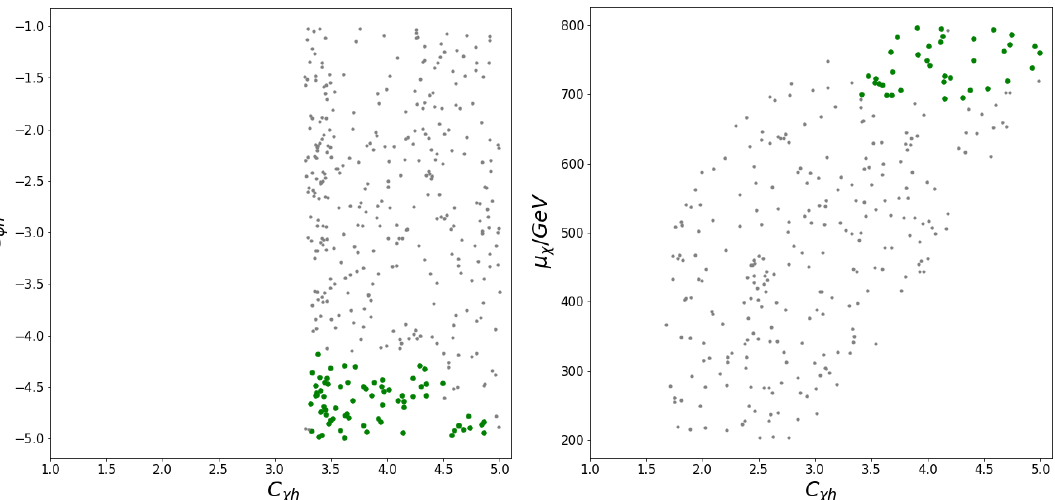
Figure 8 . Fixing tan β = 1 , n χ = n ψ = 10 . Left: we present non-exhaustive scans of the c χh - c ψh plane over the range c χh ∈ (1 , 5) and c ψh ∈ ( − 1 , − 5) , we fix the other parameters to be m H,H = 2 TeV , µ χ = 0 . 77 TeV, µ ψ = 1 . 5 TeV, µ H = 150 GeV , Λ = 2 TeV, c χ = − 0 . 2 . Right: + ,H A we show scans of the c χh - µ ψ plane for c χh ∈ (1 , 5) , and µ χ / GeV ∈ (200 , 800) for the other parameters we take m H,H = 2 TeV, µ ψ = 1 . 5 TeV, µ H = 150 GeV , Λ = 2 TeV, c χ = − 0 . 2 , c ψh = − 4 . 7 . + ,H A For both panels green points indicate parameter values that pass all of our requirements, namely a strong-first order phase transition at temperatures above 400 GeV. Grey points indicate parameter values for which SNR is achieved in excess of 200 GeV, but the phase transition is inappropriate for EWBG.